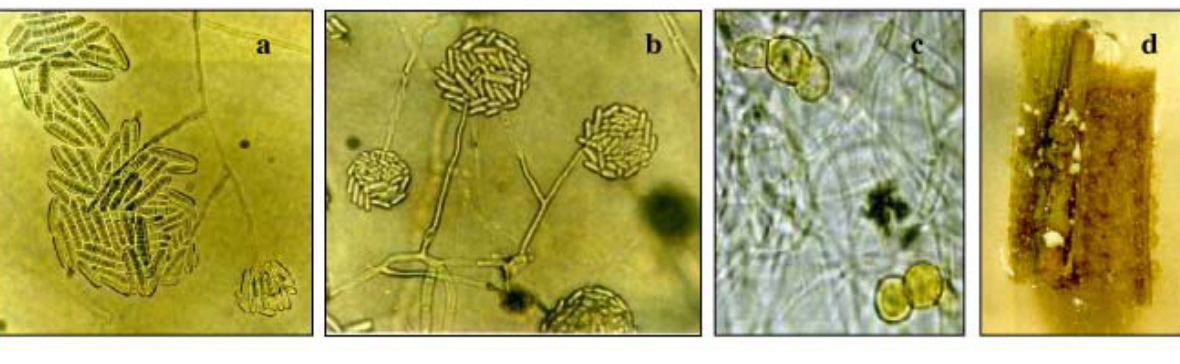
Fig. 2. Cylindrocarpon destructans : (a) macroconidia with 3 septa and microconidia ( (cid:1) (cid:31)400); (b) microconidia formed in phialides ( (cid:1) (cid:31)630); (c)(cid:31)chlamydospores ( (cid:1) 630);